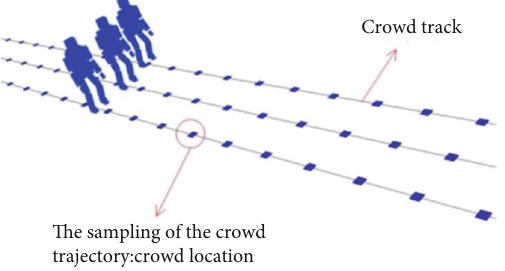
Figure 2: Crowd trajectories and sampling